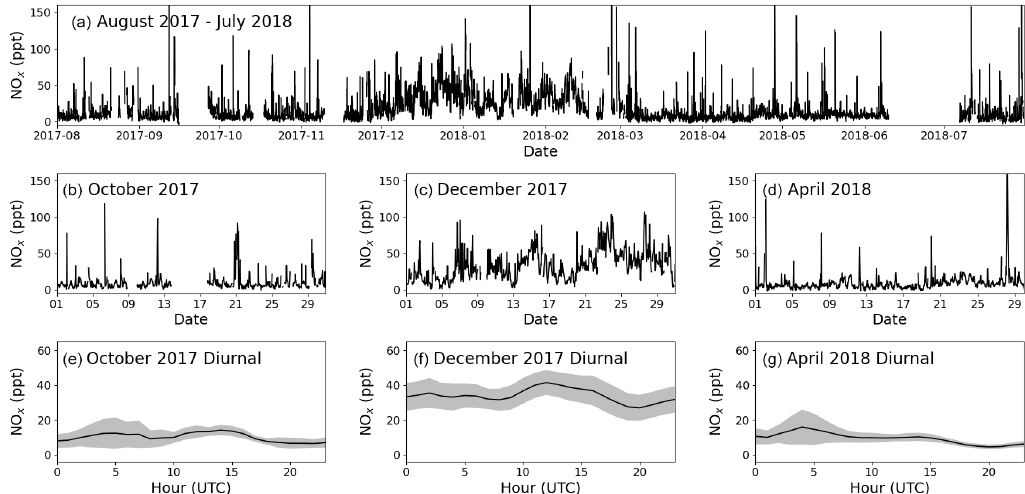
Figure 9. Panel (a) shows the time series for total NO x (NO + NO 2 PLC) from 1 August 2017 to 31 July 2018. Panels (b) , (c) , and (d) zoom in on October 2017, December 2017, and April 2018, respectively. Panels (e) , (f) , and (g) show the average diurnal of NO x for October 2017, December 2017, and April 2018, respectively, with the coloured areas being ± 2 standard errors. If there are fewer than 15 measurements available for the hour, it is not included in the